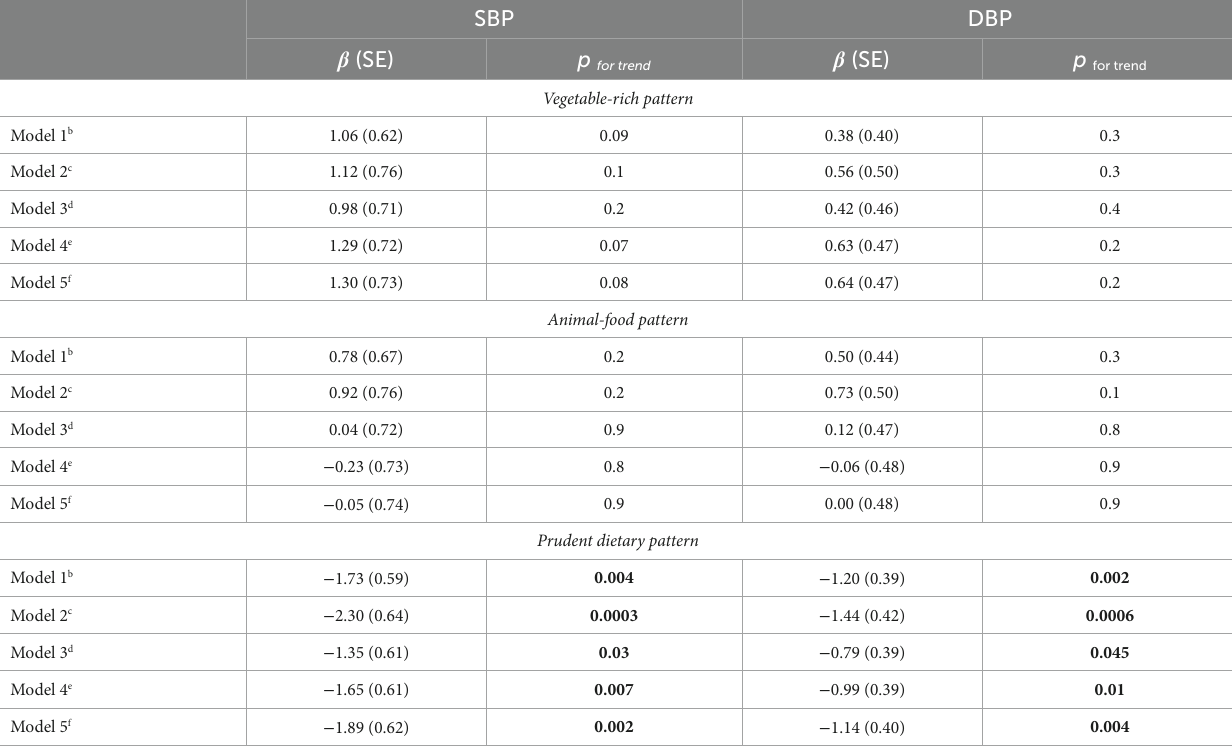
TABLE 5 Association between dietary patterns and blood pressure a .